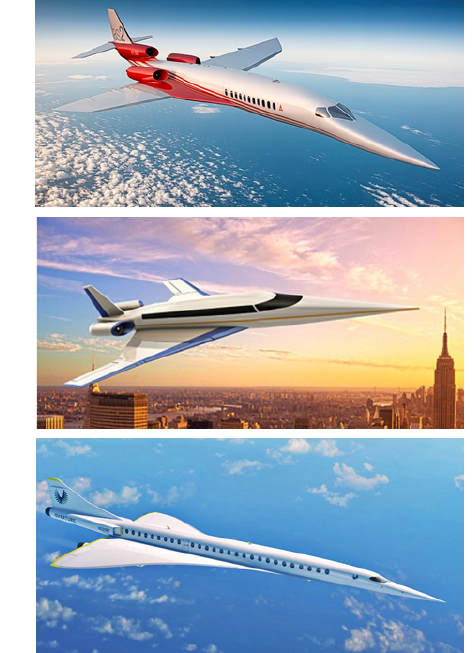
Figure 1. Aerion AS2, Spike S-512, and Boom Overture aircraft. From